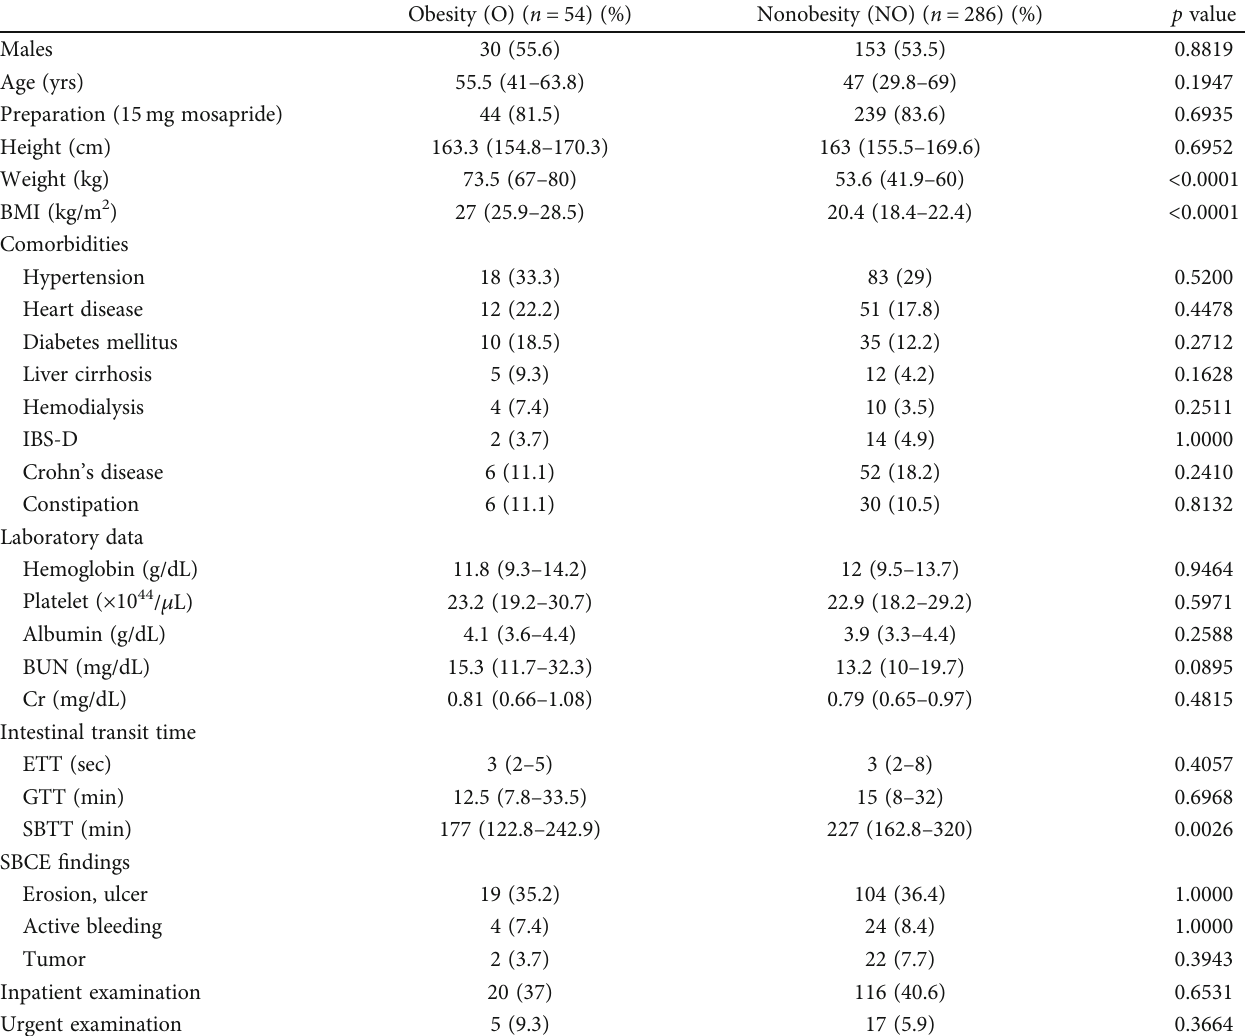
Table 2: Background factors and intestinal transit times with and without